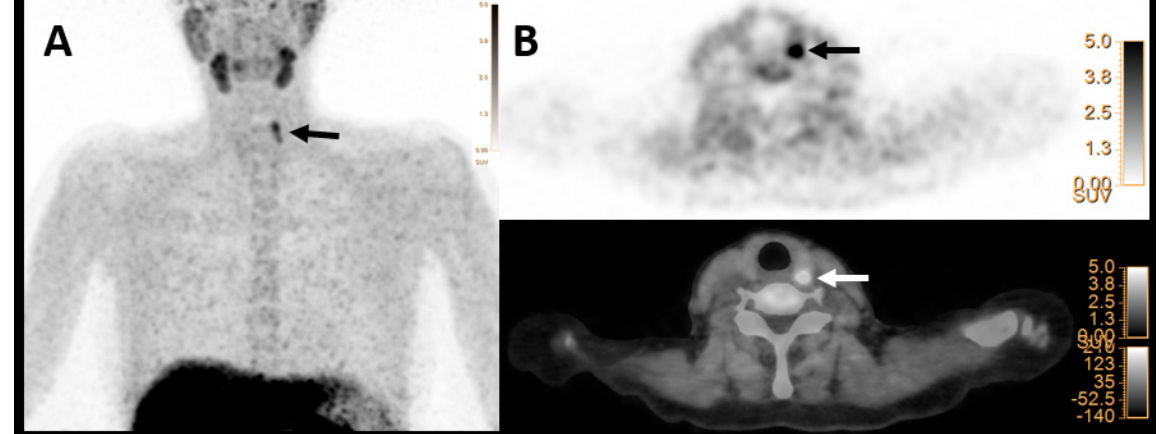
Figure 3. [ 18 F]FCH PET/CT images ( A , B ) in a 53-year-old woman with elevated serum PTH of 73 pg/mL (normal value = 16–65) and calcium level of 2.70 mmol/L (normal value = 2.13–2.63), respectively. ( A ) Maximum intensity projection (MIP) shows focal tracer uptake in the cranial part of the left thyroid lobe (arrow). ( B ) Transaxial PET image (upper row) and hybrid PET/CT (lower row) images show focal tracer uptake posterior to the upper pole of the left thyroid lobe with SUVmax of 8.2 and mSAD = 8.2mm, which was found to be hyperplasia on histopathology result.